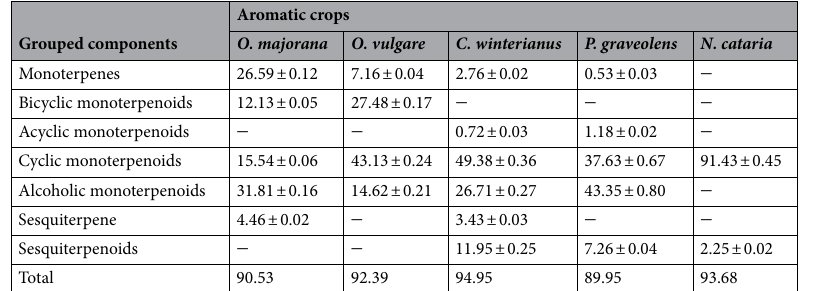
Table 2. The grouped components (area %) of essential oil in aromatic medicinal plants grown in the mid hill conditions of the western Himalaya. The values are mean ± standard deviation.